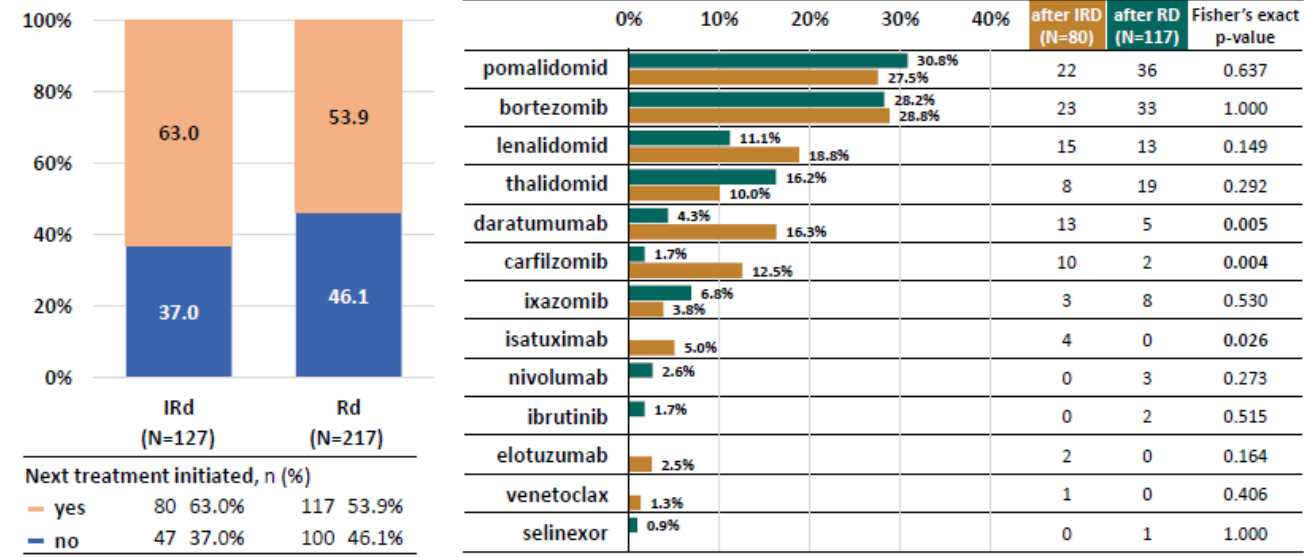
Figure 6. Next treatment after IRD/RD.